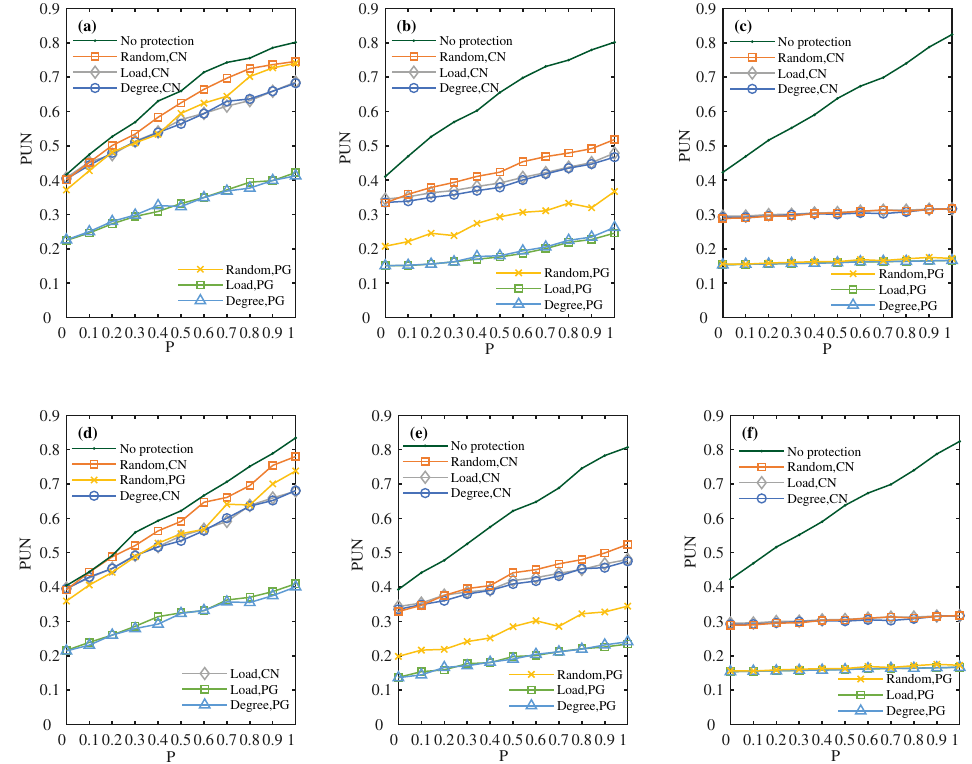
Figure 6. The effects of different protection strategies of critical nodes on Robustness of CPS under ( a ) η = 0.1, Node–Link, RC; ( b ) η = 0.5, Node–Link, RC; ( c ) η = 0.9, Node–Link, RC; ( d ) η = 0.1, Node–Node, RC; ( e ) η = 0.5, Node–Node, RC; ( f ) η = 0.9, Node–Node,